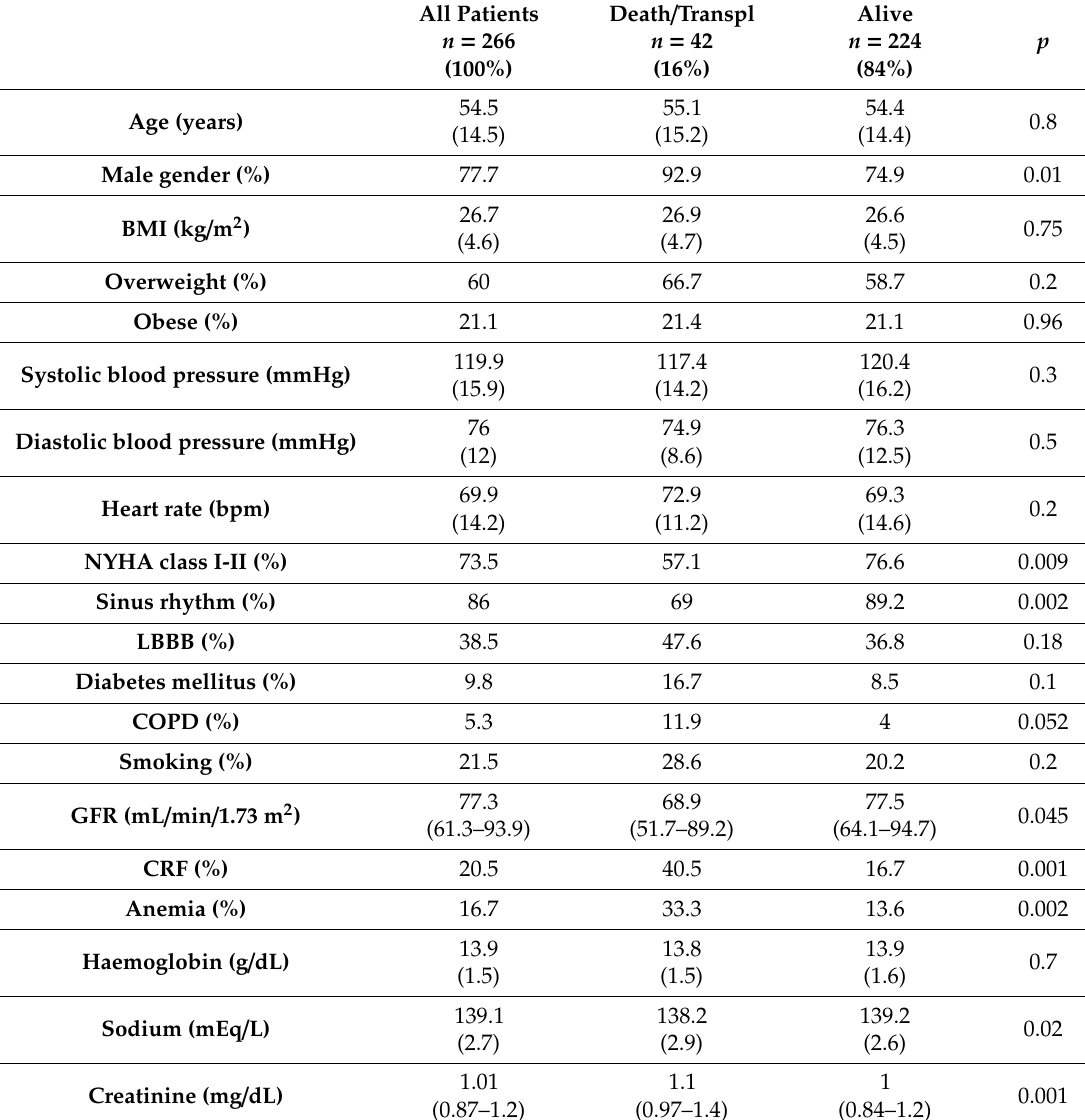
Table 6. Main characteristics of patients stratified by the end-point death / heart transplantation during the